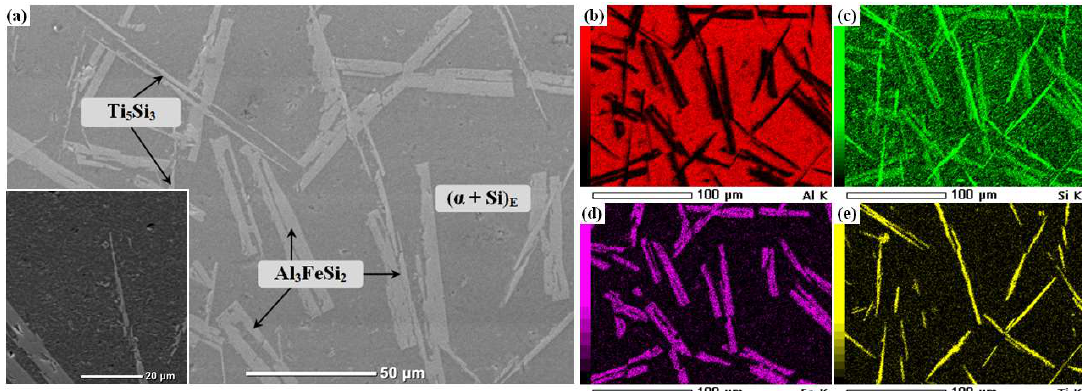
Figure 9. ( a ) Backscattered electron image of AlSiFe with 3 wt. % Ti alloy, eutectic microstructure as insert. Elemental mapping of ( b ) aluminum, ( c ) silicon, ( d ) iron, and ( e ) titanium. (α+Si) E = Eutectic.